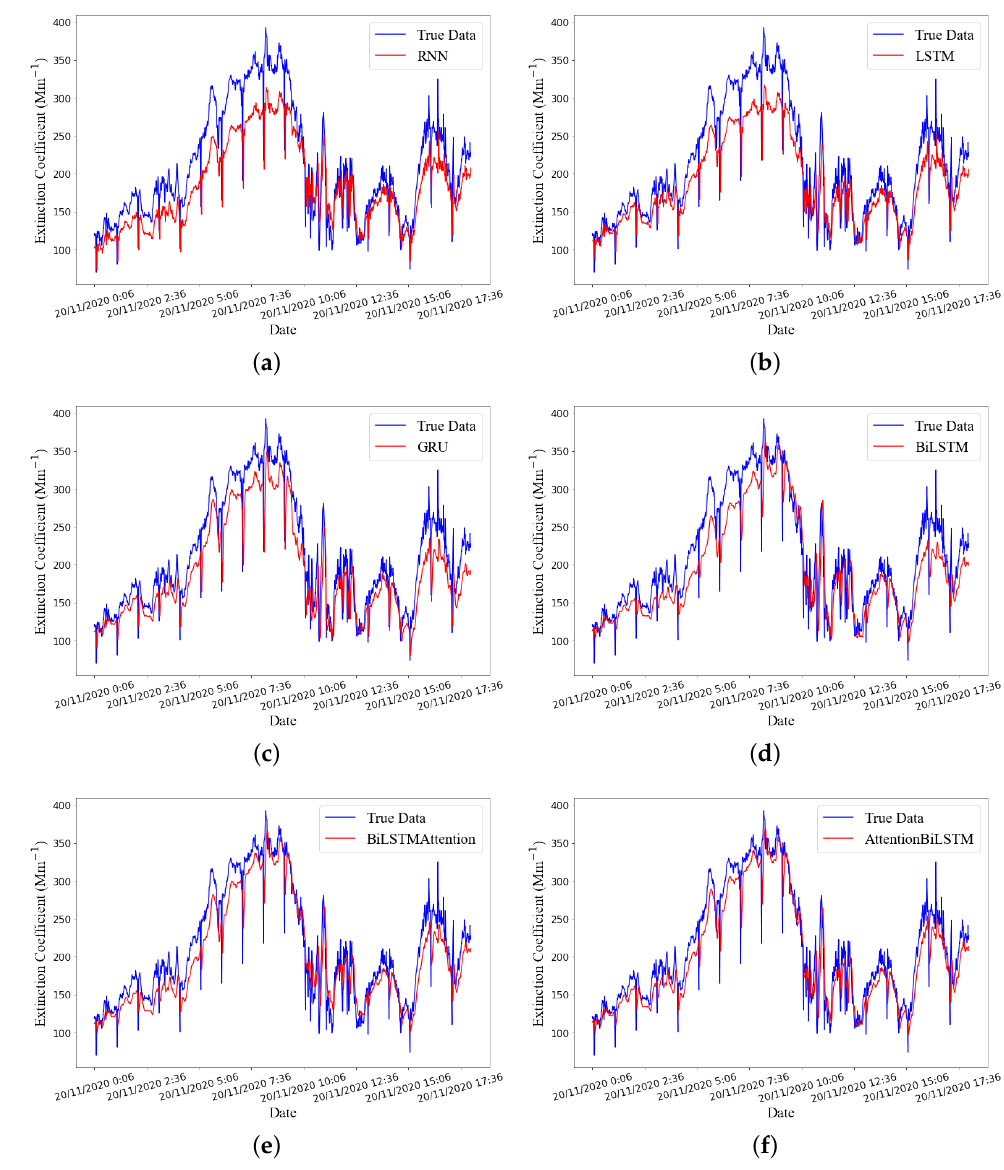
Figure 11. The performance of prediction in dataset B by using ( a ) RNN, ( b ) LSTM, ( c ) GRU, ( d ) BiLSTM, ( e ) BiLSTMAttention, and ( f ) Proposed